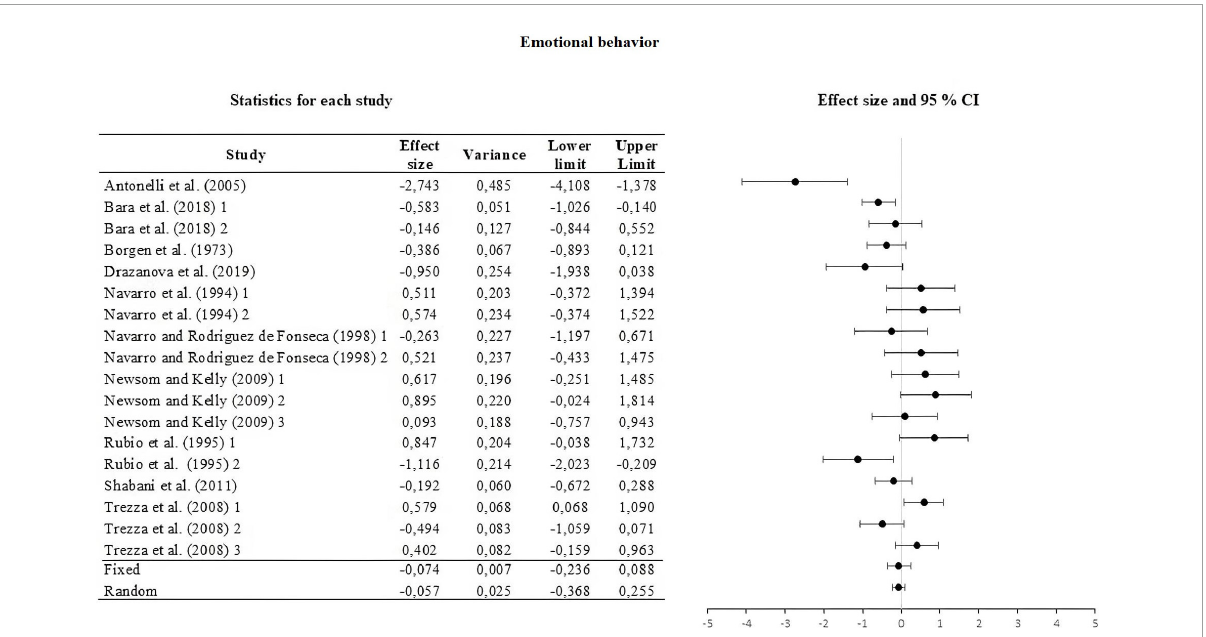
FIGURE4 Forest plot of the effect sizes and estimated confidence intervals of the UAs that evaluated emotional behavior. For the integrated effect size Cohen’s d was used. The lines indicate the effect sizes of each UA and its corresponding 95% confidence intervals. The last two lines represent the result under a fixed and random effect model, respectively. The lower and upper limits and the variance of each UA are reported.